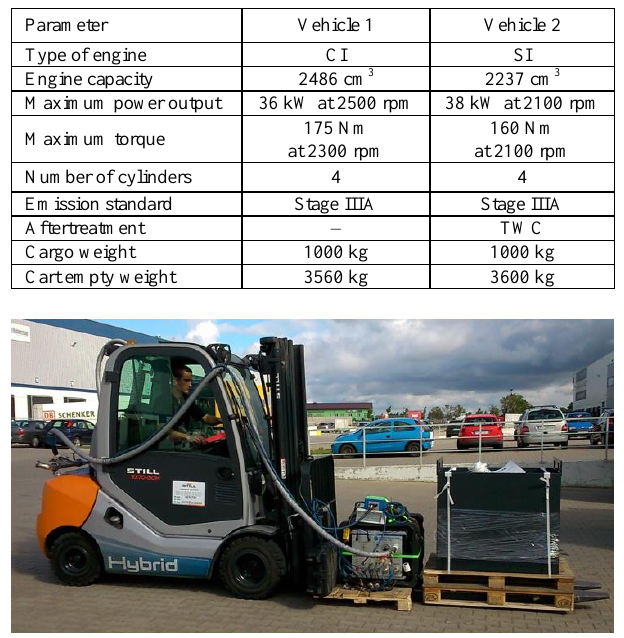
Fig. 1. Research object with installed measurement equipment